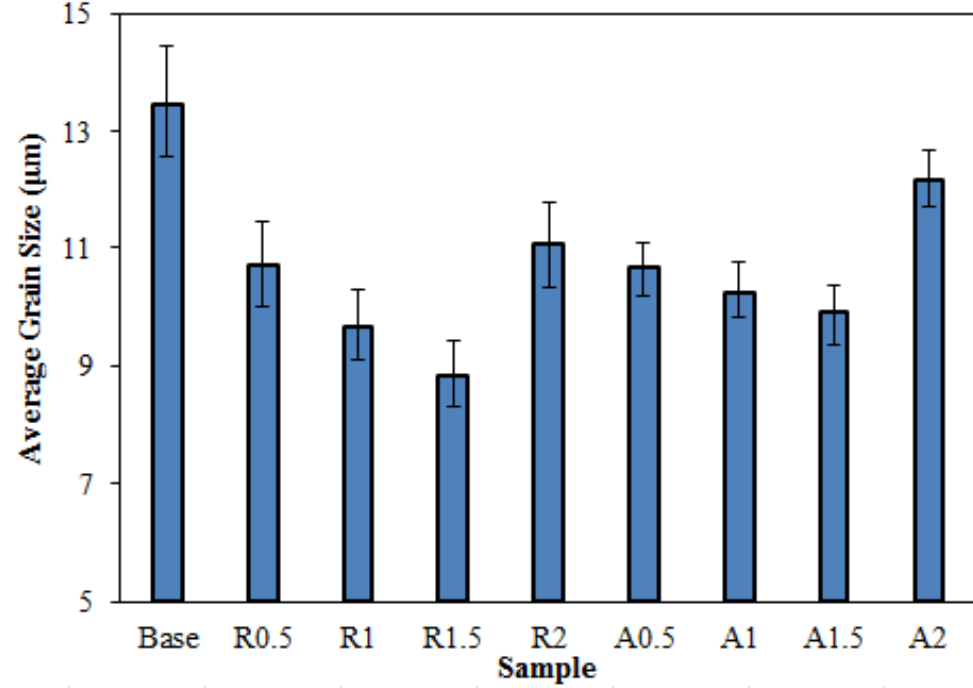
Figure 15. Comparison of average SZ grain size of welded specimens.